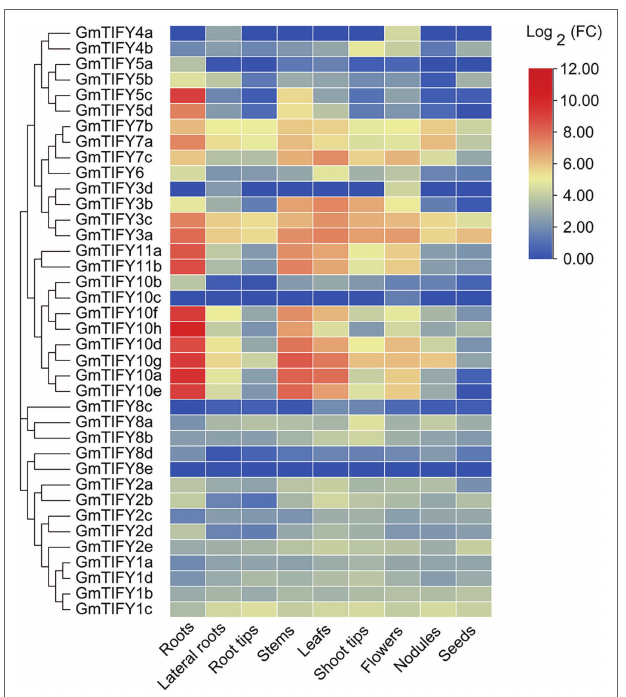
FIGURE 6 | The expression profiles of 38 GmTIFY genes under different conditions including drought, salt and ABA